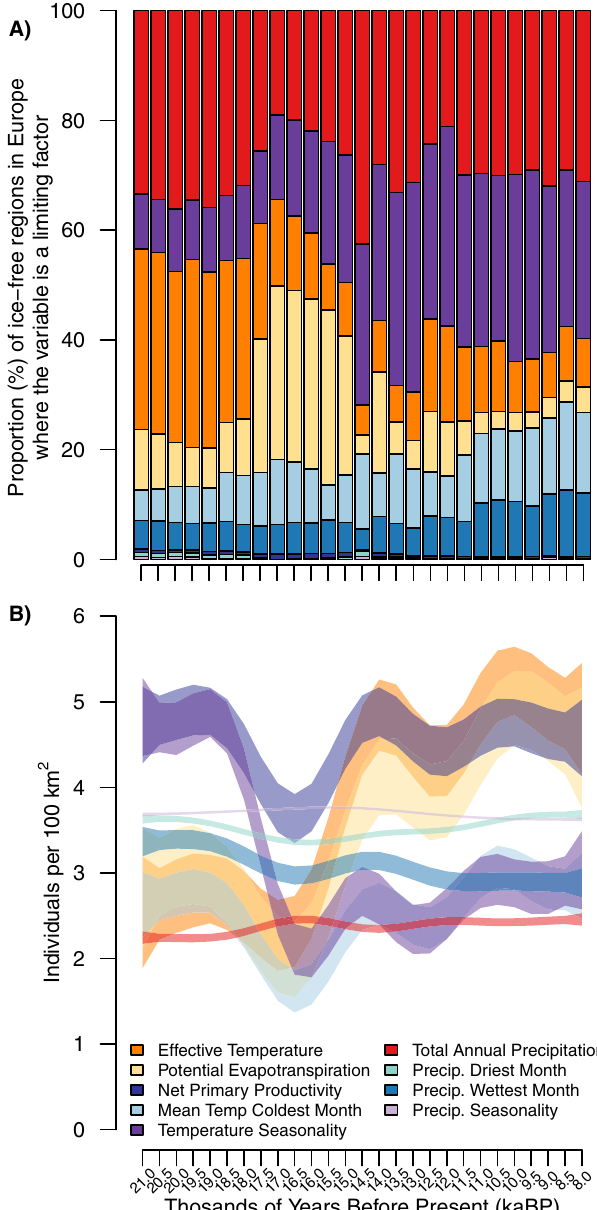
Fig. 6 | Summary of European-wide limiting factors to population density during the Pleistocene-Holocene transition. Proportion of the ice-free area of Europe where each variable was estimated to be the factor limiting population density ( A ) and estimated population size based on the mean environmental con- ditions for each century ( B